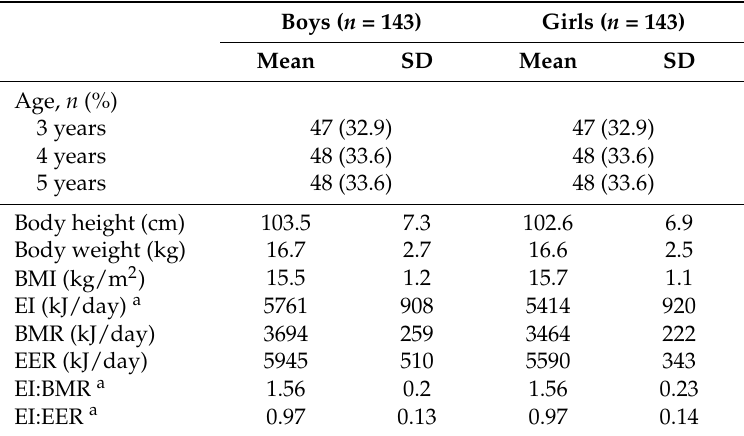
Table 1. Basic characteristics of